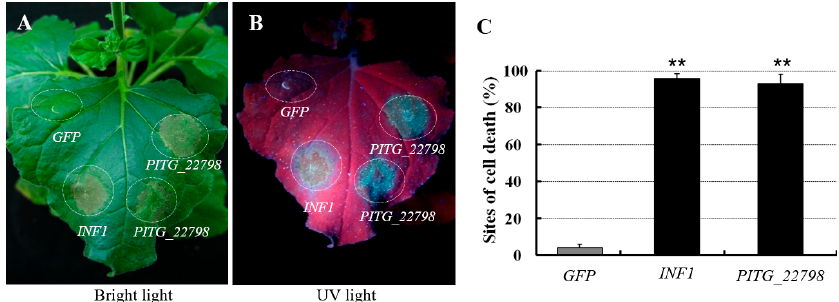
Figure 2. PITG_22798 -induced cell death in Nicotiana benthamiana. Images show cell death induced by PITG_22798 under white light ( A ) and UV light ( B ). Plant leaves were in fi ltrated with A. tumefaciens cells containing a potato virus X (PVX) vector carrying genes INF1 (positive control, OD600 = 0.4), PITG_22798 (OD600 = 0.4), or GFP (Green Fluorescent Protein) (negative control, OD600 = 0.4). All pictures were taken at 6 days post-infiltration (dpi). ( C ) The graph shows the percentage of inoculation sites showing cell death. Three N. benthamiana plants and four leaves per plant were used for each test. Values are means ± SD. The experiment has been repeated three times with similar results. Asterisks denote values signi fi cantly different from GFP ( p < 0.01, t -test).